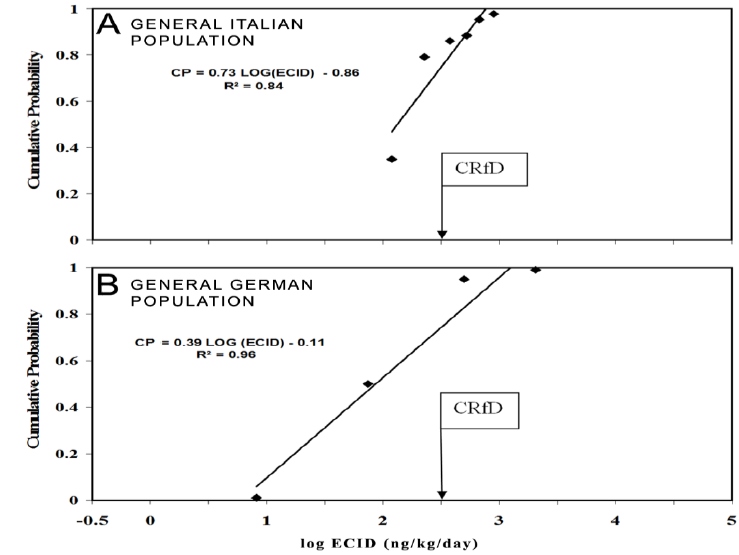
Figure 4. Cumulative probability distributions (CPD) for the ECID with the following: ( A ) 42 individuals in the general Italian population in the Pavia, Siena and Trento regions during 1997 (results reported for the ranges of TCP concentrations; ( B ) 50 individuals in the general German population of Meklenburg-Vorpommern regions (results reported at the maximum, median and 95 percent value) (see Sections